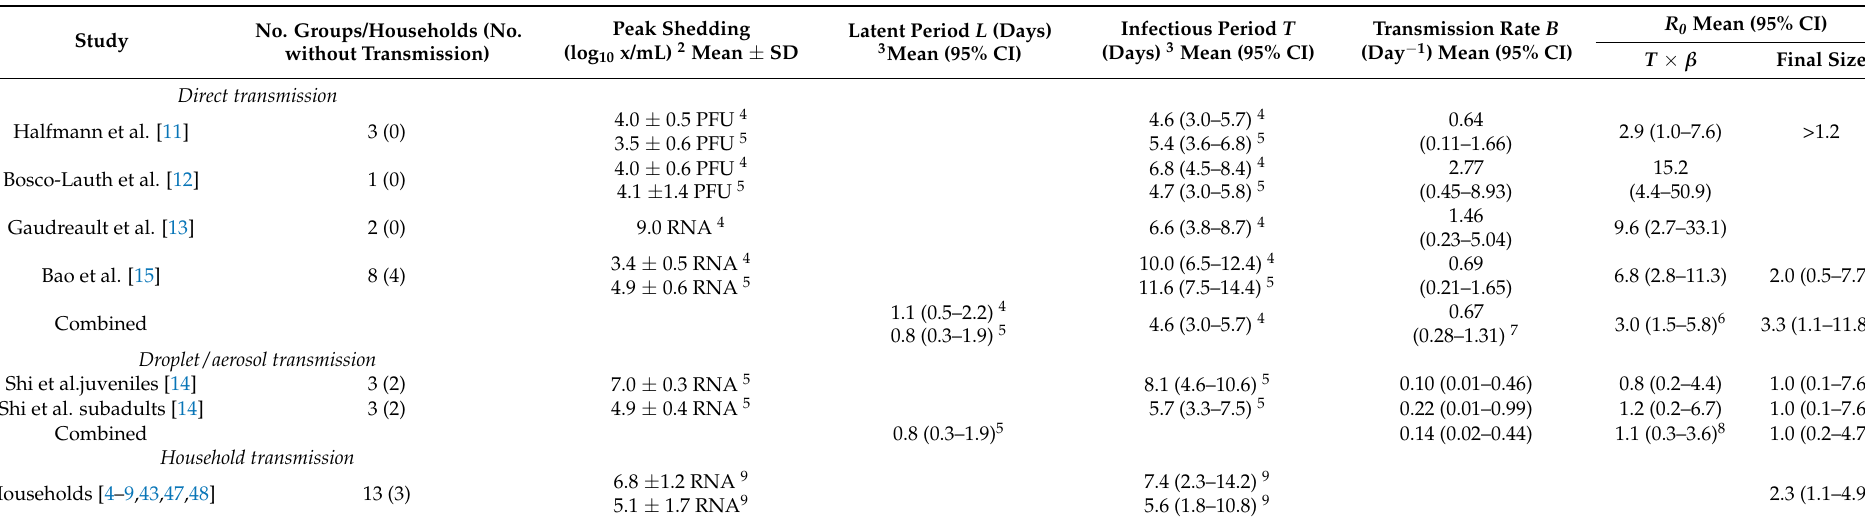
Table 3. Quantified parameters for direct contact and droplet transmission of SARS-CoV-2 between cats using data from transmission experiments or observational studies describing infection and transmission at household level 1